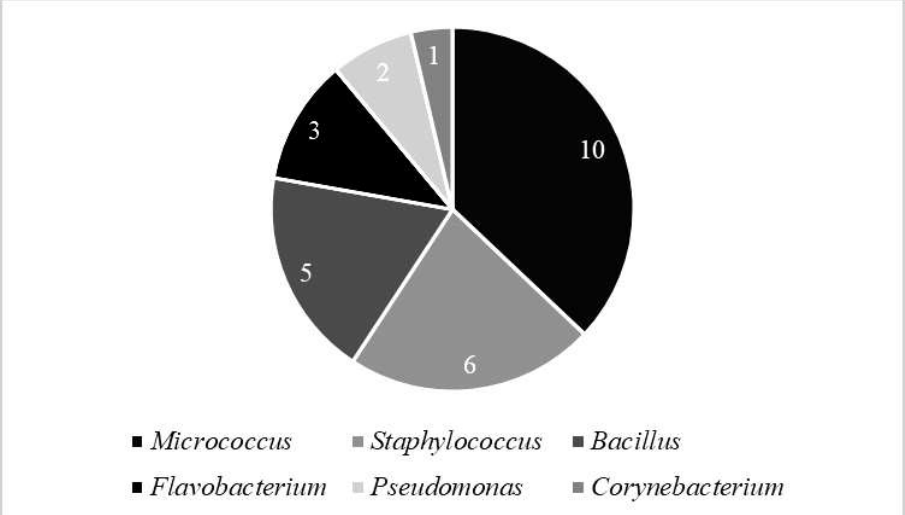
Figure 1. The isolated genera of bacteria and the number of strains.